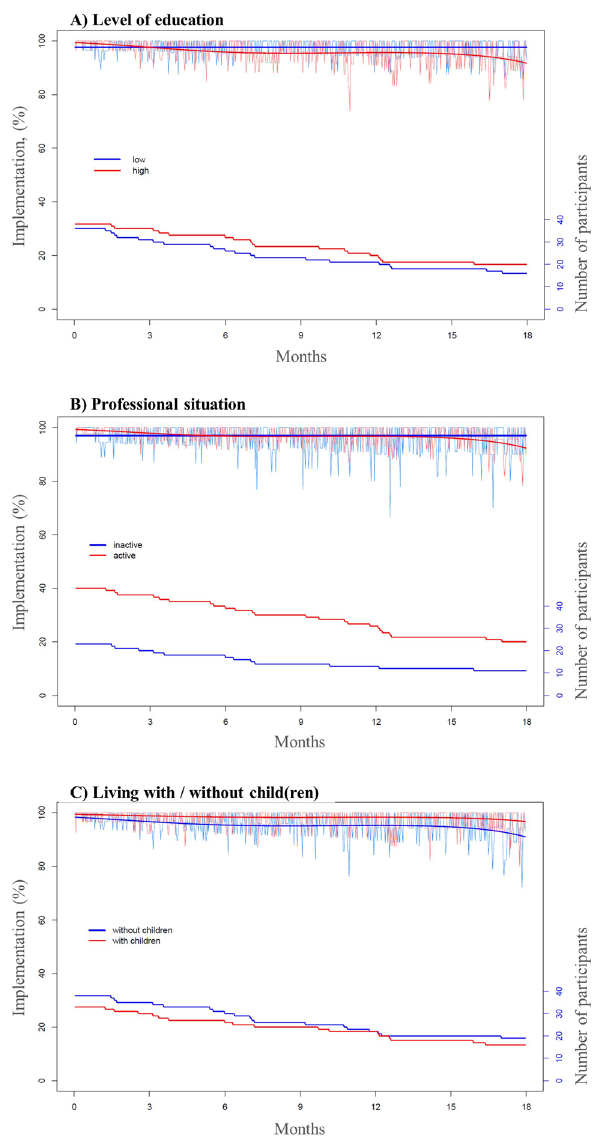
Figure 3. Influence of the level of education ( A ), professional situation ( B ), and living with child(ren) ( C ) on implementation by patients taking